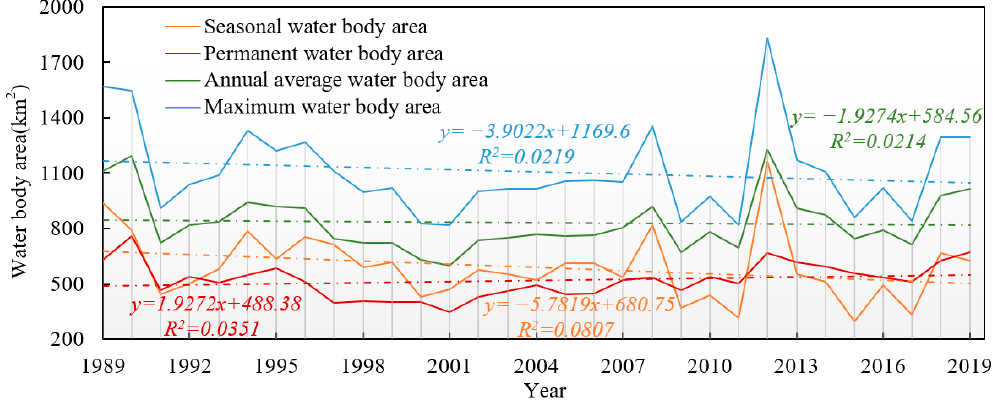
Figure 6. 1989–2019 interannual variation trend of the water body area of different water body types (maximum, seasonal, permanent, and annual average) in the Hetao Plain.